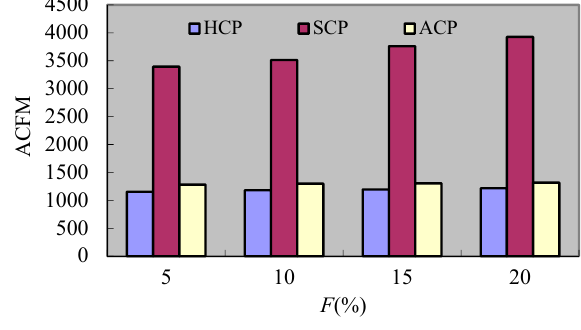
Figure 16. Impact of F on ACFM.